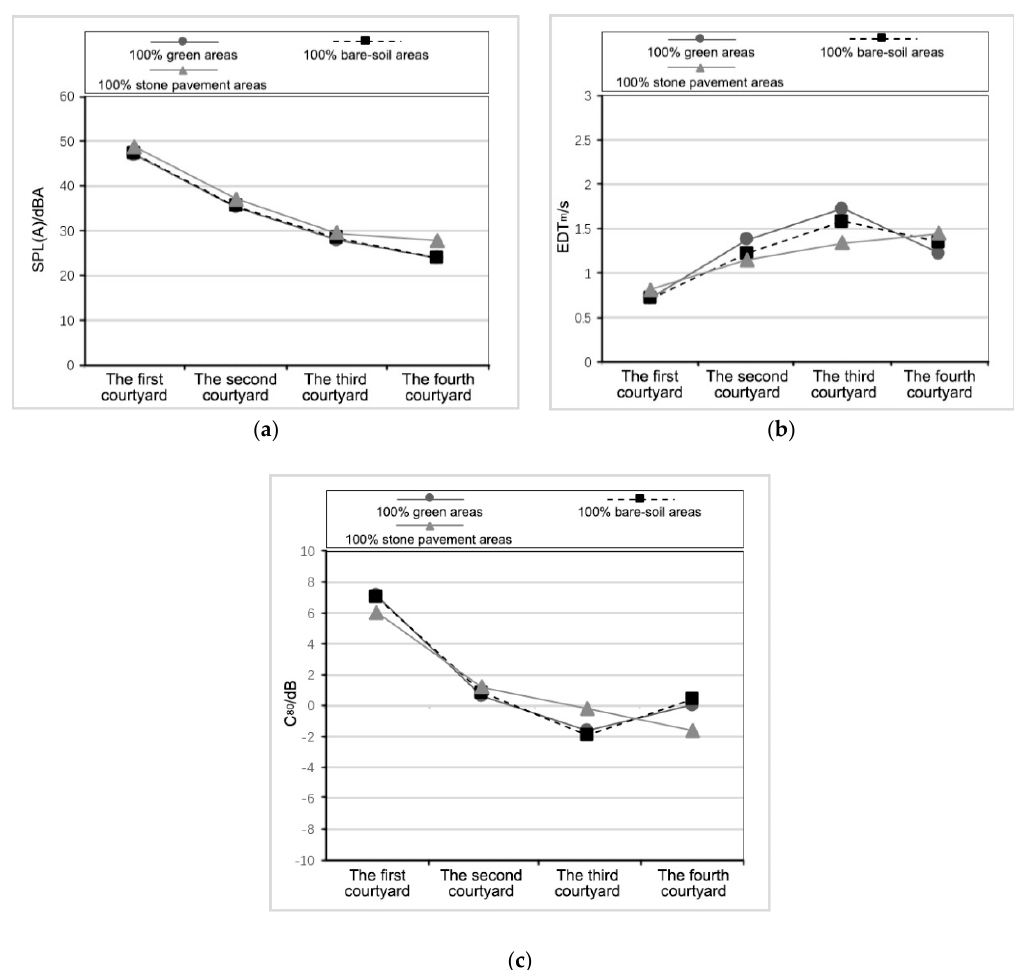
Figure 12. Diagrams of the effects of flooring materials on courtyard sound fields. ( a ) Variation in SPL(A). ( b ) Variation in EDT m . ( c ) Variation in C 80 .